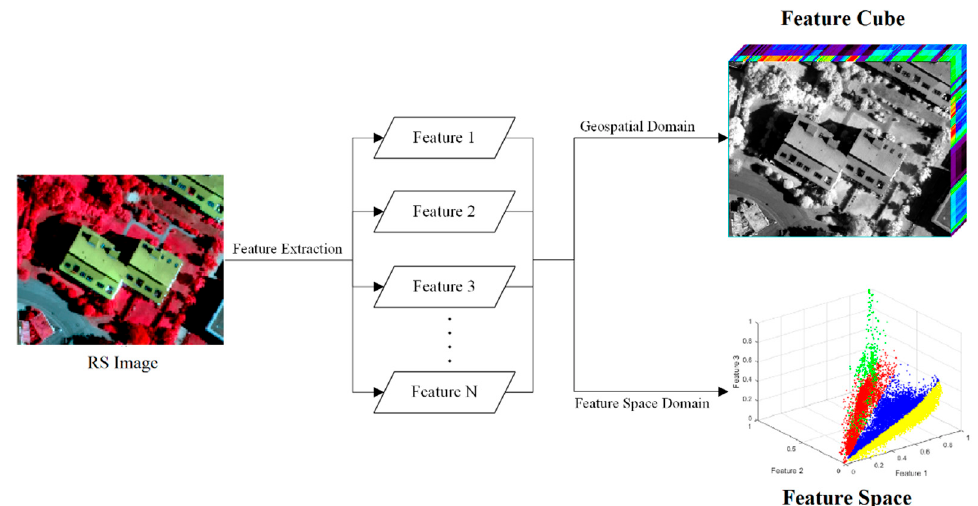
Figure 2. N -dimensional “feature cube” and feature space for a remote sensing (RS) image.